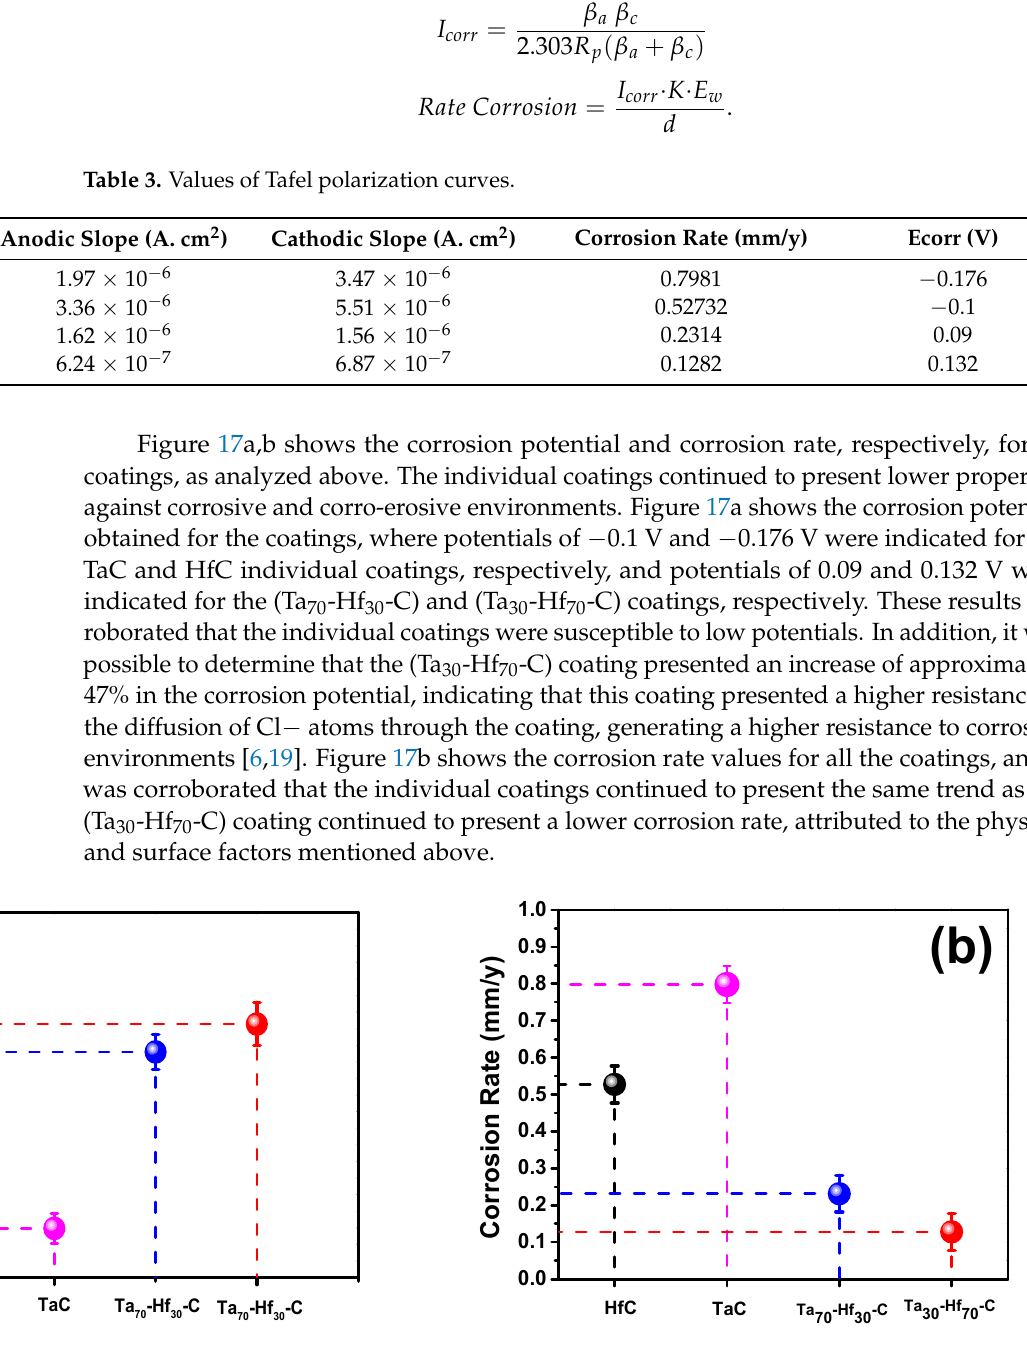
Figure 17. ( a ) Corrosion potential and ( b ) corrosion rate for all coatings.